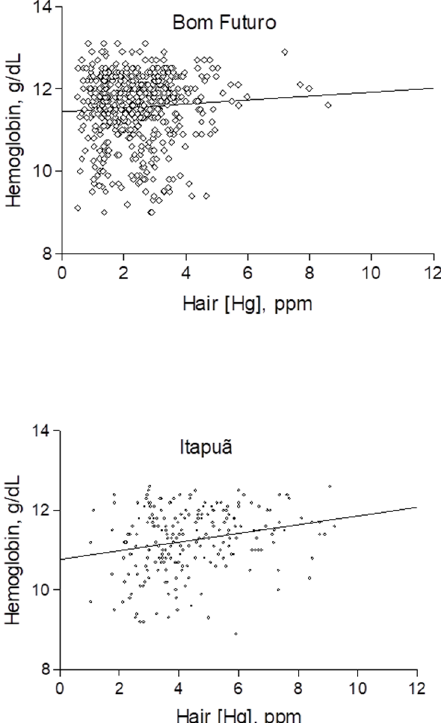
Figure 2. Correlation between hair-Hg concentrations (a marker of fish consumption) and hemoglobin (Hb) concentrations according to villages.